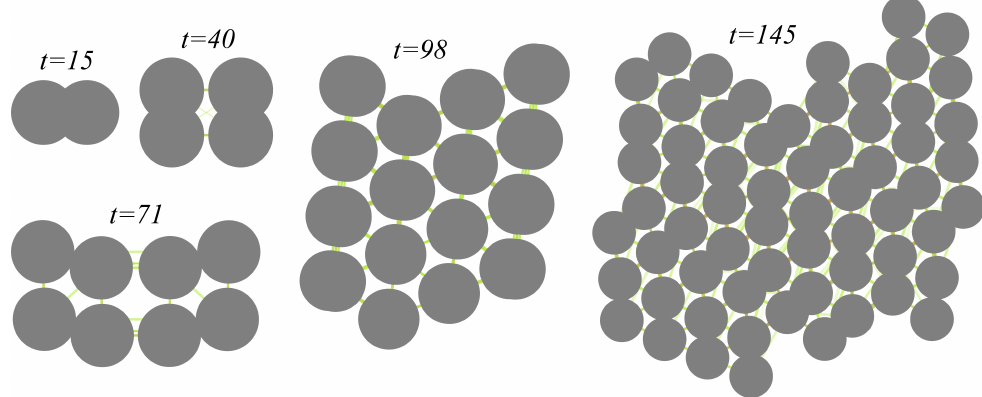
Figure 3. Snapshots of free tumor growth at the designated times under k T = 200, K = 0.32, and other parameter values from the basic set (see Table 1). Green lines correspond to adhesive interactions, with the lengths of the bonds l > l 0 , and these lines become transparent as l → l max . Orange and red lines denote repulsive interactions, with the lengths of the bonds l < l 0 , and these lines become darker with decreasing l